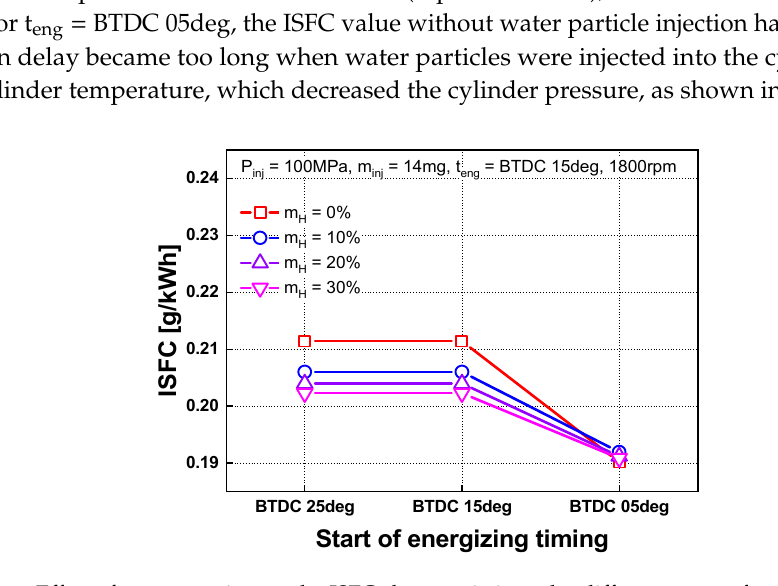
Figure 11. Effect of vapor portion on the ISFC characteristic under different starts of energizing timing (P inj = 100 MPa, m inj = 14 mg, 1800 rpm).